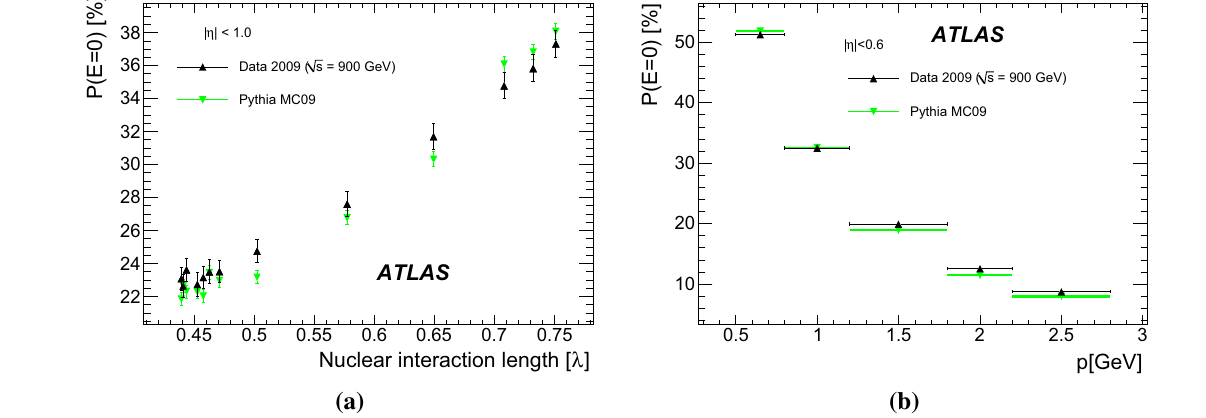
measured in terms of the nuclear interaction length λ nucl . The tracks are reconstructed within | η | < 1. The likelihood to reconstruct E = 0 as a function of the incoming track momentum is shown for the same data and MC simulations in b , for reconstructed tracks within | η | < 0 . 6. Both figures are taken from Ref.